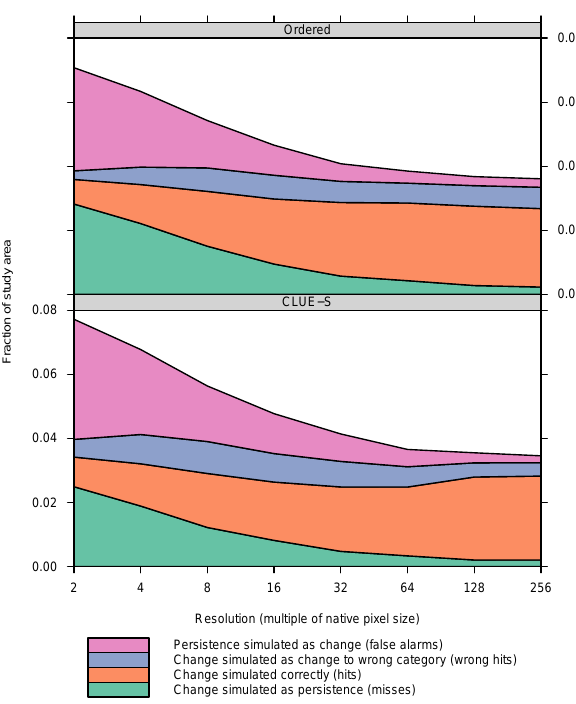
Figure 7. Agreement budget for the transition from forest to built for the two model outputs considering reference maps at 1985 and 1999 and simulated map for 1999. The plot shows the number of correctly allocated change increases as the map resolution coarsens.